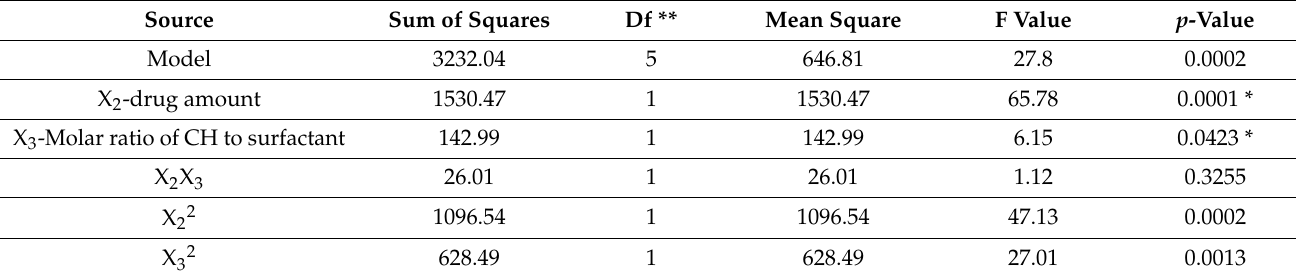
Table 7. Analysis of Variance (ANOVA) of the drug entrapment